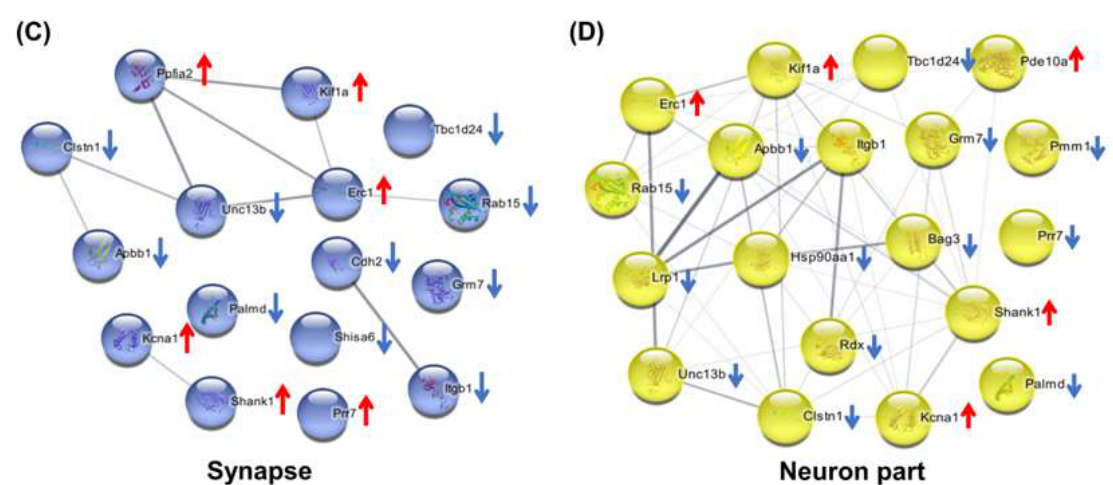
Figure 4. Bioinformatics analysis of the differentially expressed proteins in the As/Ctrl group. ( A –